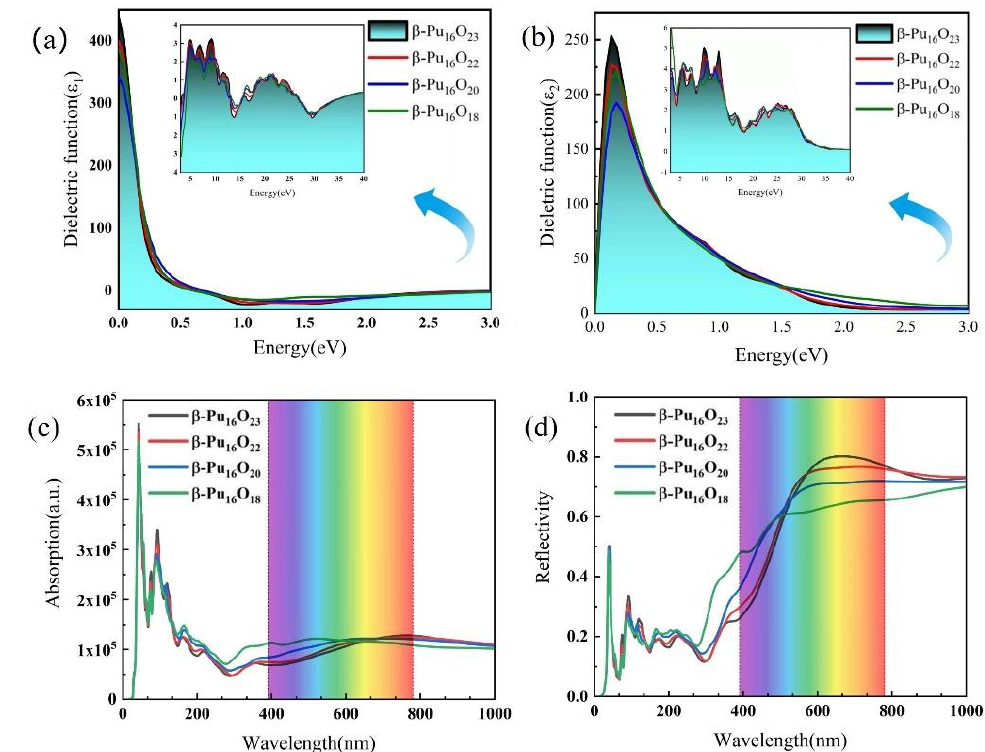
Figure 7. Real ε 1 ( ω ) , imaginary ε 2 ( ω ) components of the dielectric function, light absorption and reflection spectra of β -Pu 16 O 23 , β -Pu 16 O 22 , β -Pu 16 O 20 and β -Pu 16 O 18. ( a ) Real part of dielectric function. ( b ) Imaginary part of dielectric function. ( c ) Absorption spectra. ( d ) Reflection spectra.